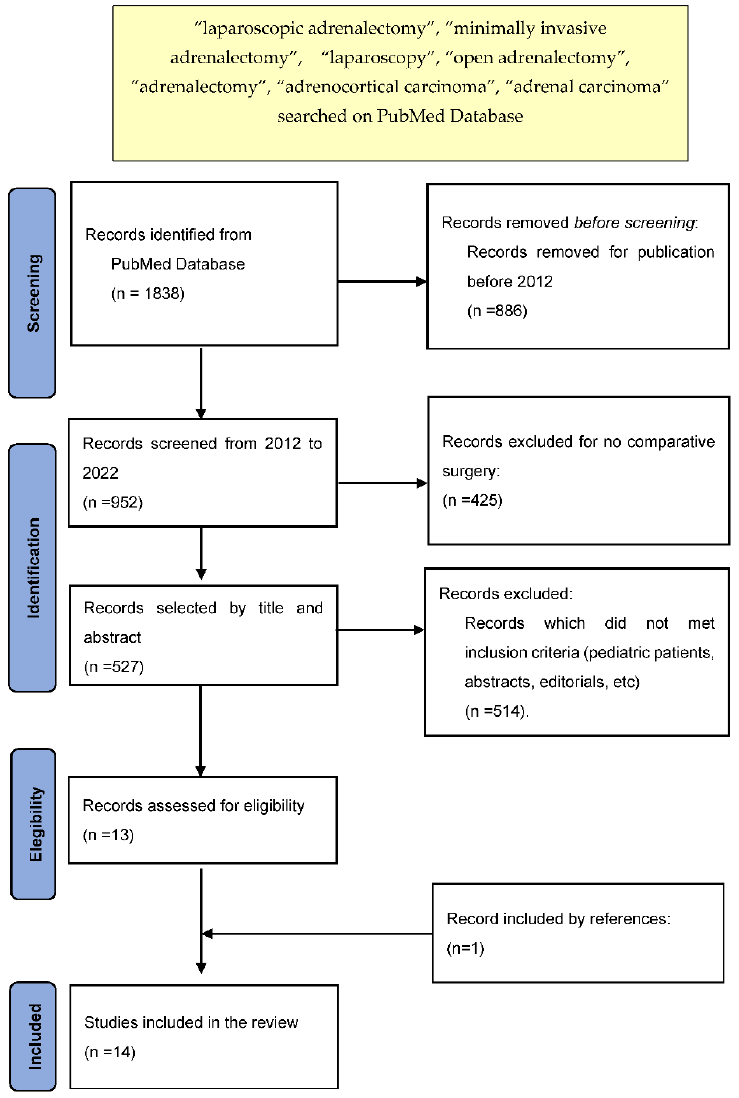
Figure 1. Prisma flow diagram.